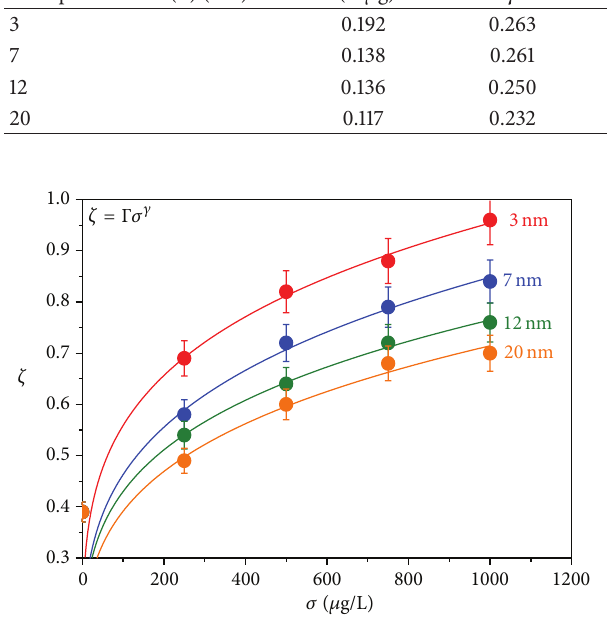
Table 2: Parameters used for fitting of the curves to the experimental data showing the variation of the ratio of nuclear volume ( 𝑉 𝑛 ) to cellular volume ( 𝑉 𝑐 ) in CS tissue layout ( 𝜁 ) of Mystus tengara with increasing ZnS nanoparticle concentration ( 𝜎 ) for a fixed exposure time ( 𝑡 = 60 days) keeping nanoparticle size ( 𝑑 ) as a parameter and the correlation coefficients between 𝜁 and 𝜎 for a fixed 𝑑 . Nanoparticle size ( 𝑑 ) (nm)